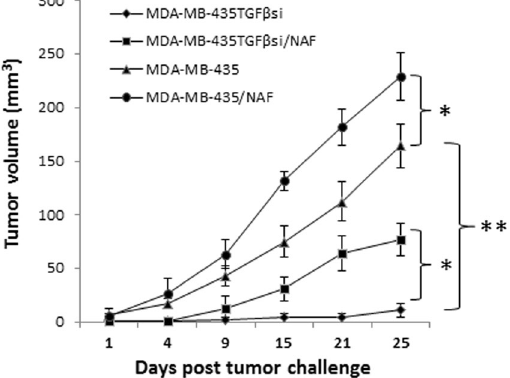
Figure 7. Effects of CAFs on the in vivo growth of primary tumors with intact or abrogated in TGF β 1 expression. Athymic nude mice were injected subcutaneously with MDA-MB-435 cells or MDA-MB- 435TGF β si cells either alone or admixed with CAFs. The cells were allowed to grow for 25 days and tumor volumes were measured every two days to determine growth kinetics. * p < 0.05; ** p <